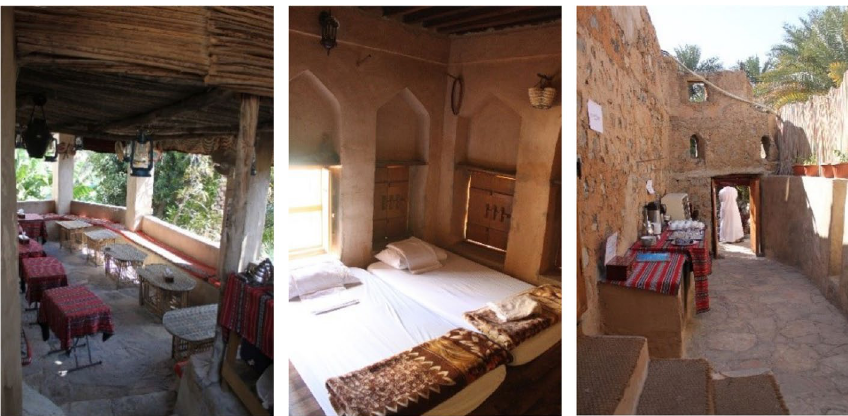
Fig. 7 Views of the different spaces in ‘Misfat Old House’, 2016 (Source: the